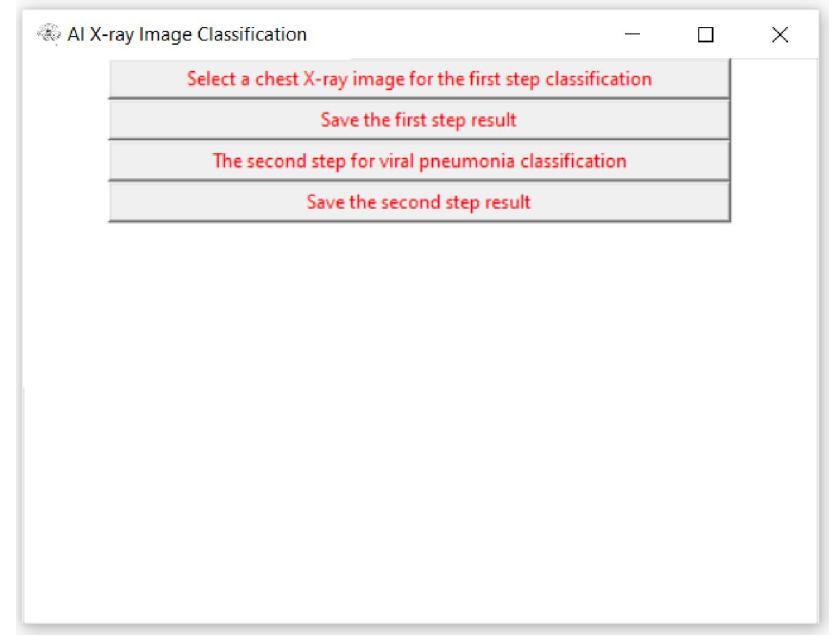
Figure 3. User interface (UI) of the